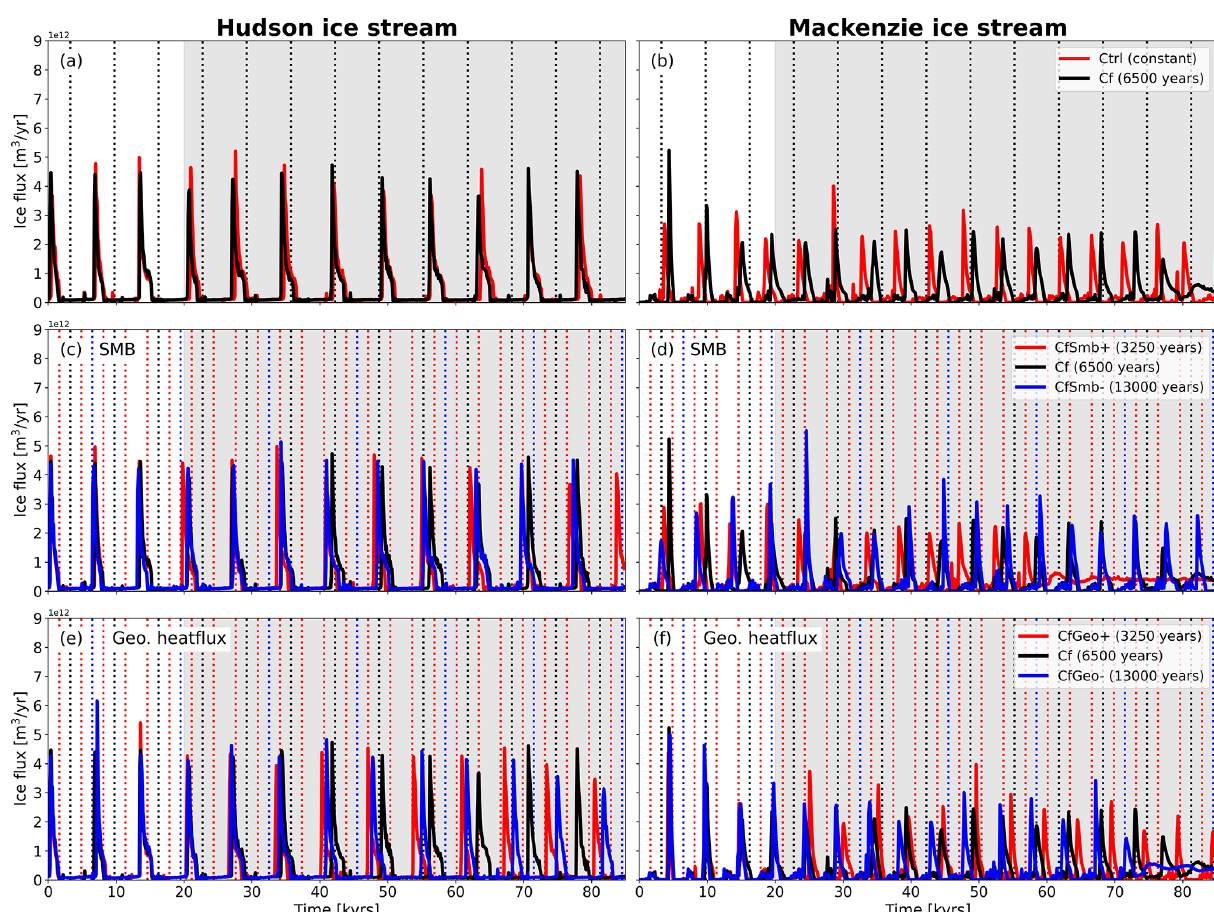
Figure 10. Similar to Fig. 3 but for Hudson (left) and Mackenzie (right) ice stream. The panels show the response to (a, b) constant and cyclic forcing, (c, d) different SMB forcing frequencies, and (e, f) different glacial isostatic adjustment frequencies. The dashed vertical lines indicate when surge should occur according to the derived forcing. Numbers in parentheses in the legends indicate forcing frequency. Grey shading highlights the analysis